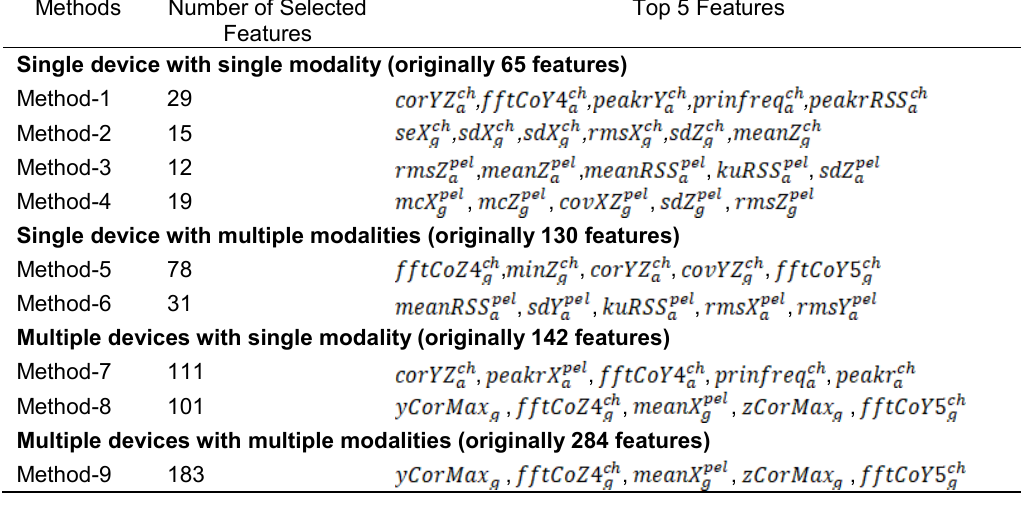
Table 4. Features selection in different methods for chest rotation.